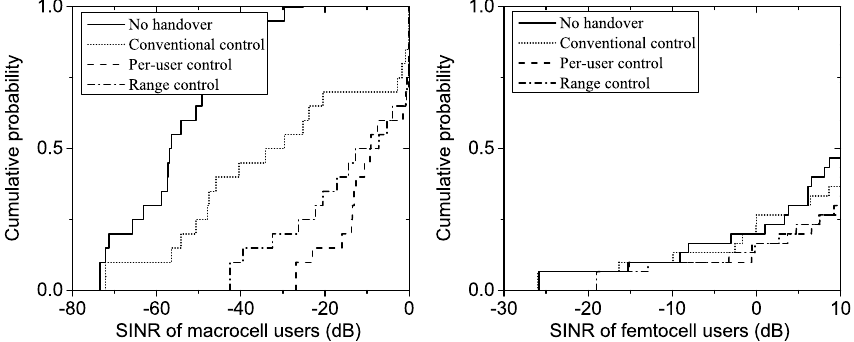
Figure 5. Probability distribution of achieved SINRs of macrocell users ( left ) and femtocell users ( right ) for different mechanisms ( M = 20, F =